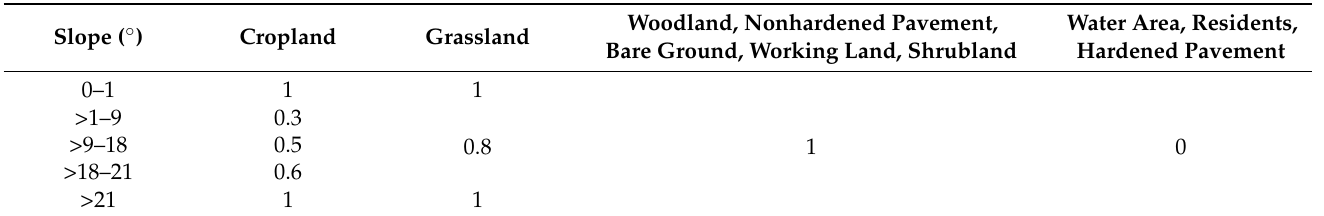
Table 2. Parameters of the P-factor.